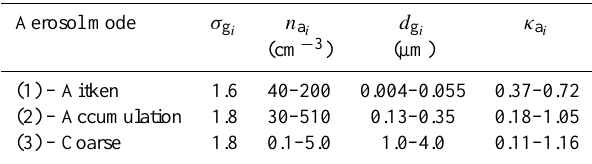
Table 1. Size distribution parameters for the 3-modal aerosol-size distribution used for evaluation of the parameterization. Each log- normal mode is characterized by the number concentration n a ometric standard deviation σ g the hygroscopicity of the mode κ a